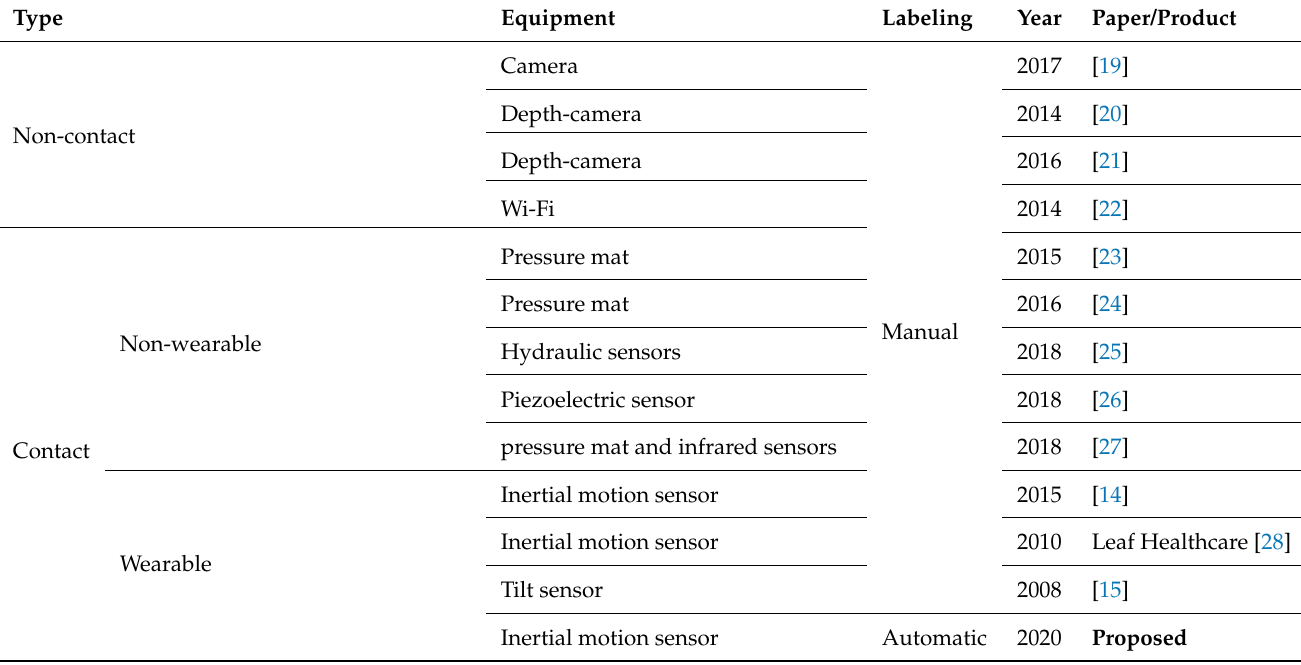
Table 1. A comparison between the proposed method and the related